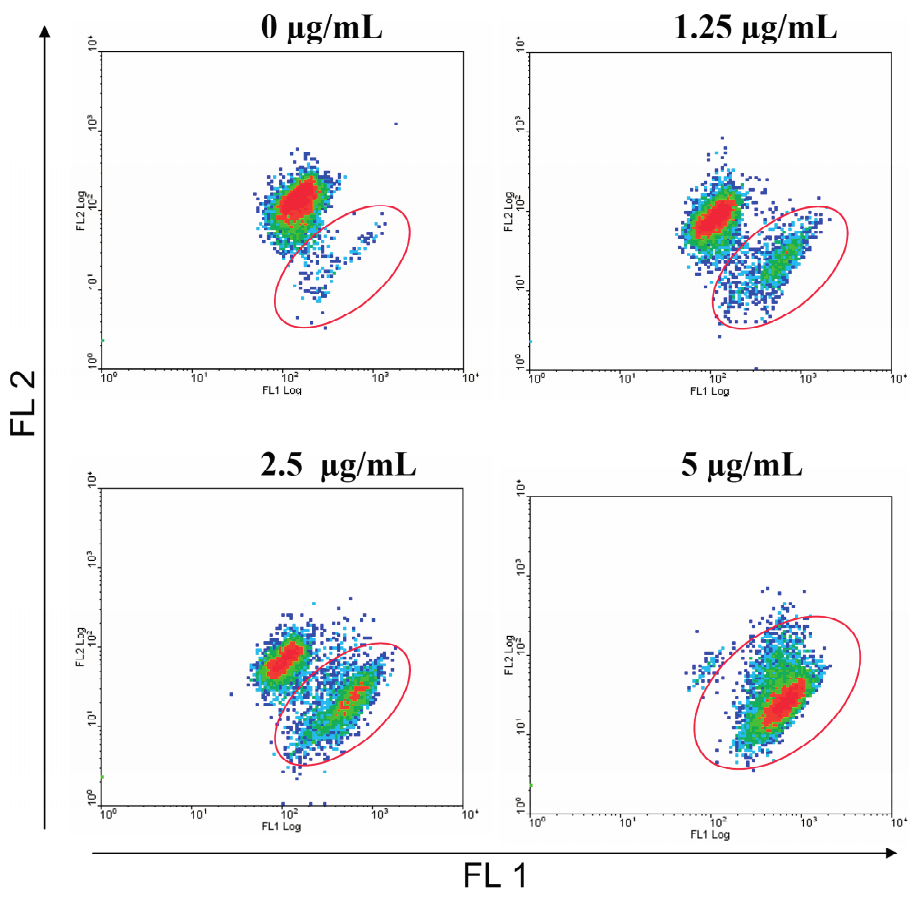
Figure 4. Flow cytometric results showing the effects of different concentrations of 3 (1.25, 2.5 and 5 μ g/mL) on the disruption of the mitochondrial membrane potential